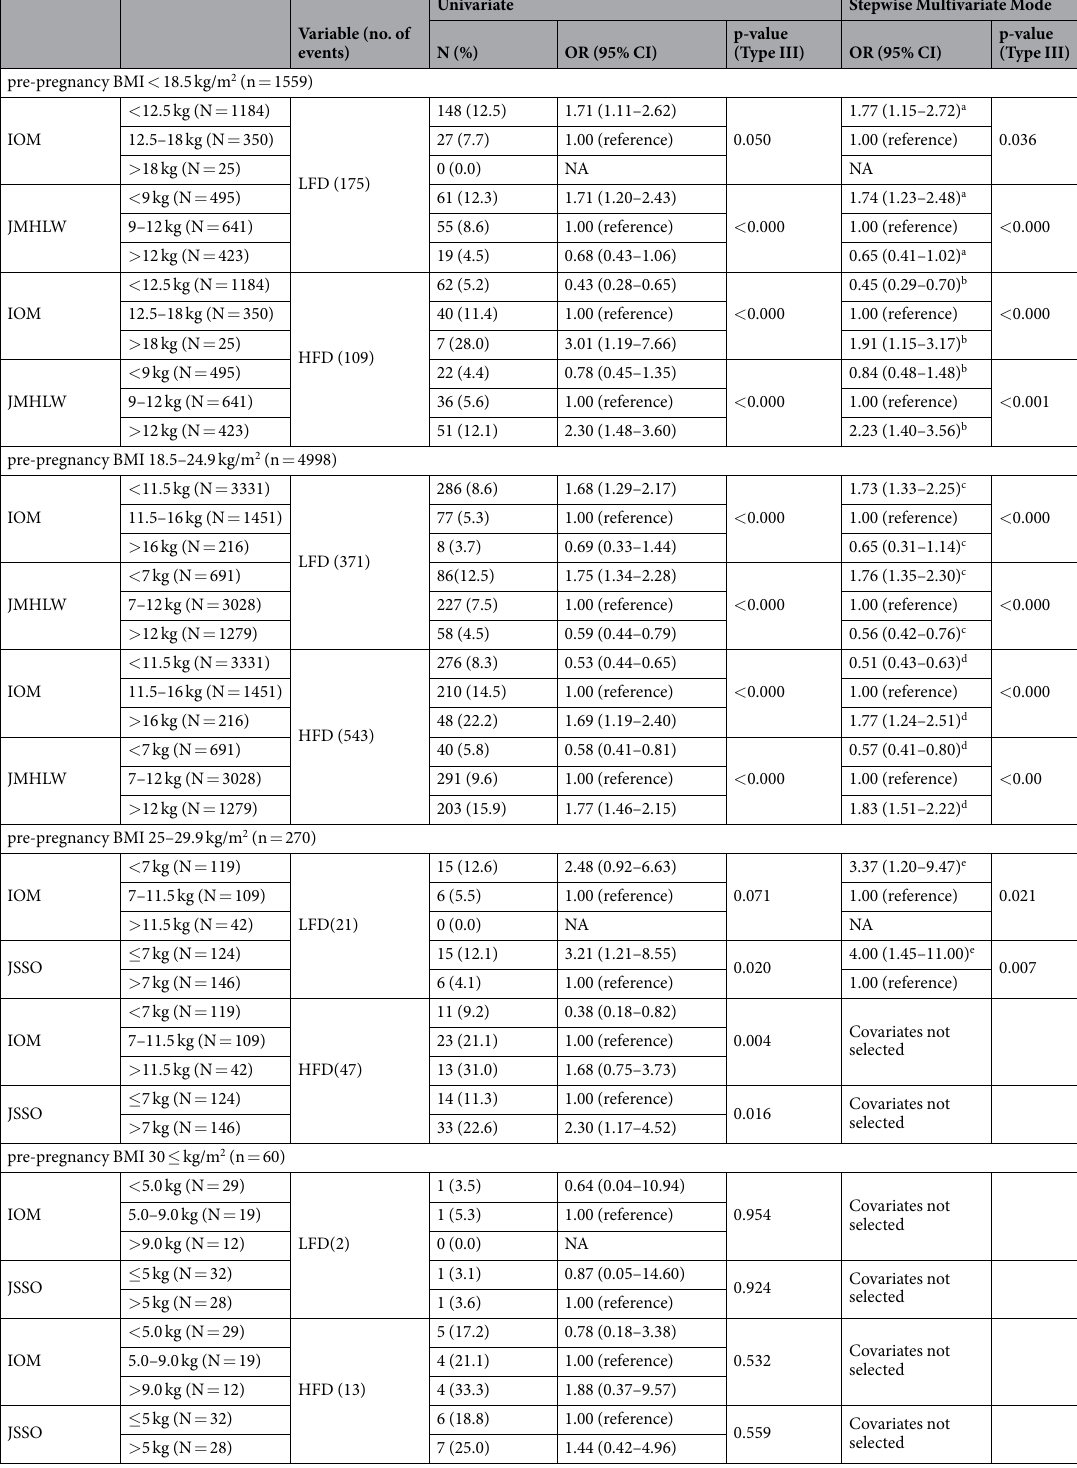
Table 2. Odds risks for a Light-for-date (LFD) or Heavy-for-date (HFD) infant according to pre-pregnancy BMI categories. a Adjusting for smoking in the estimation of the risk for LFD. b Adjusting for nulliparity in the estimation of the risk for HFD. c Adjusting for age, cesarean section, and smoking in the estimation of the risk for LFD. d Adjusting for age and cesarean section in the estimation of the risk for HFD. e Adjusting for cesarean section in the estimation of the risk for